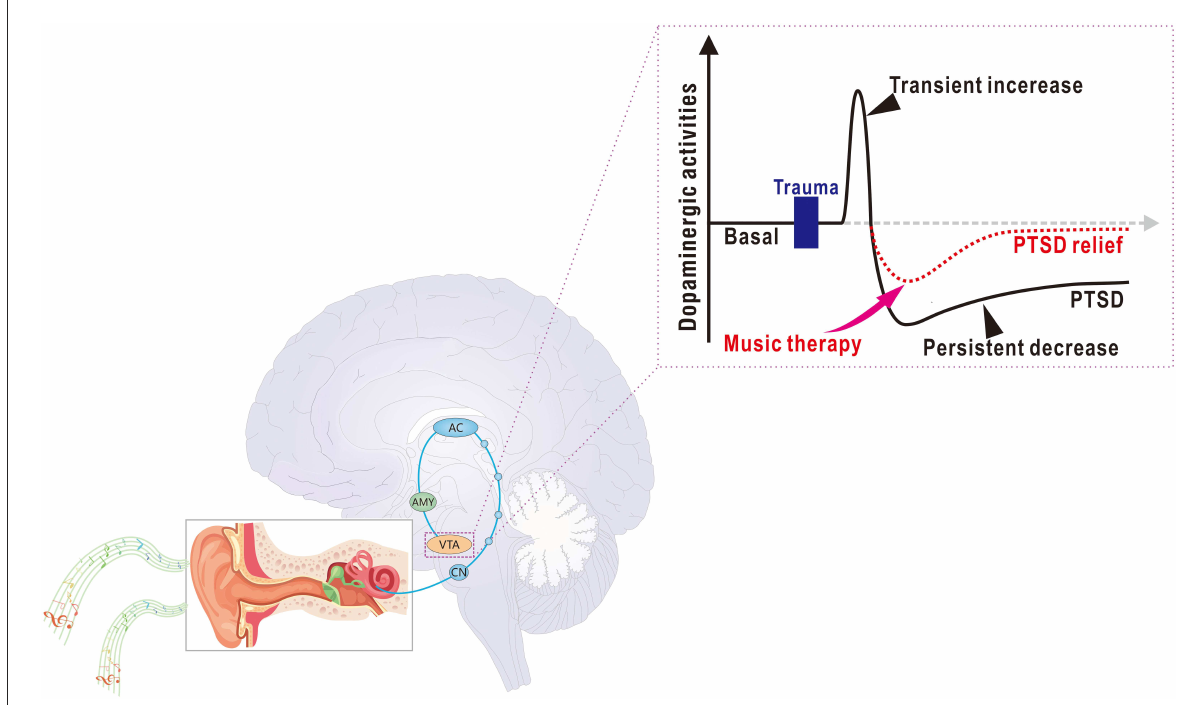
FIGURE2 Schematic illustration of music therapy on post-traumatic stress disorder (PTSD) through dopaminergic action. A simplified neural pathway for acoustic processes from the cochlea to the auditory cortex. The auditory cortex sends projections to the amygdala and then to the ventral tegmental area (VTA) (Koelsch, 2014). Inset, the DA level is transiently elevated after trauma, followed by persistent hypodopaminergia (Corralfrias et al., 2013). Music activates the VTA function and stimulates the DA release, which may reduce PTSD-induced hypodopaminergia in the brain, which ameliorates PTSD symptoms. CN, cochlear nucleus; AC, auditory cortex; AMY, amygdala; VTA, ventral tegmental